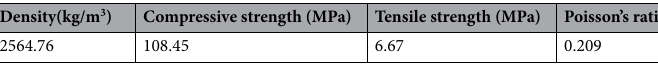
Table 1. The key parameters of rock properties.